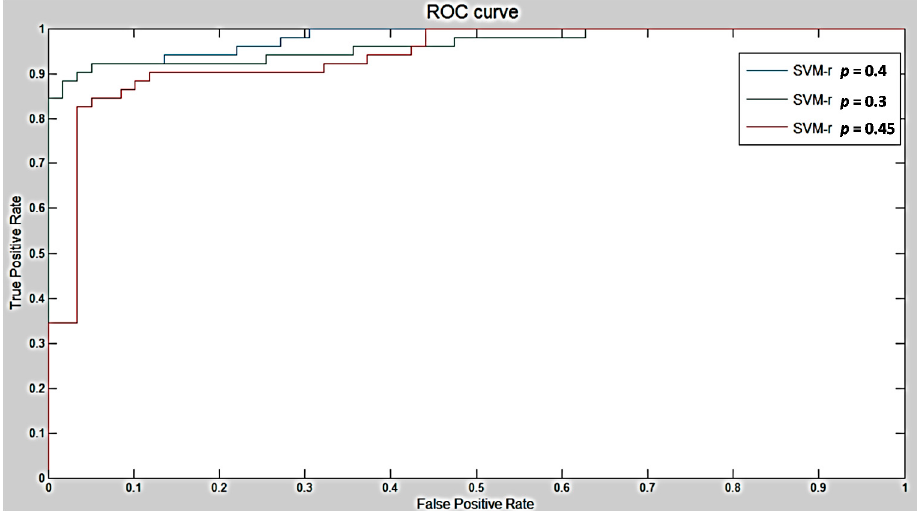
Figure 8. Receiver Operating Characteristic (ROC) Curves based on different epsilon index using the same radial in basis function kernel.